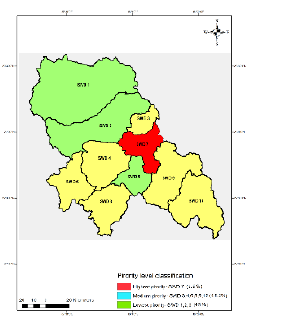
Table 15: Priority level and type allocation of sub- watershed of upper watershed of river